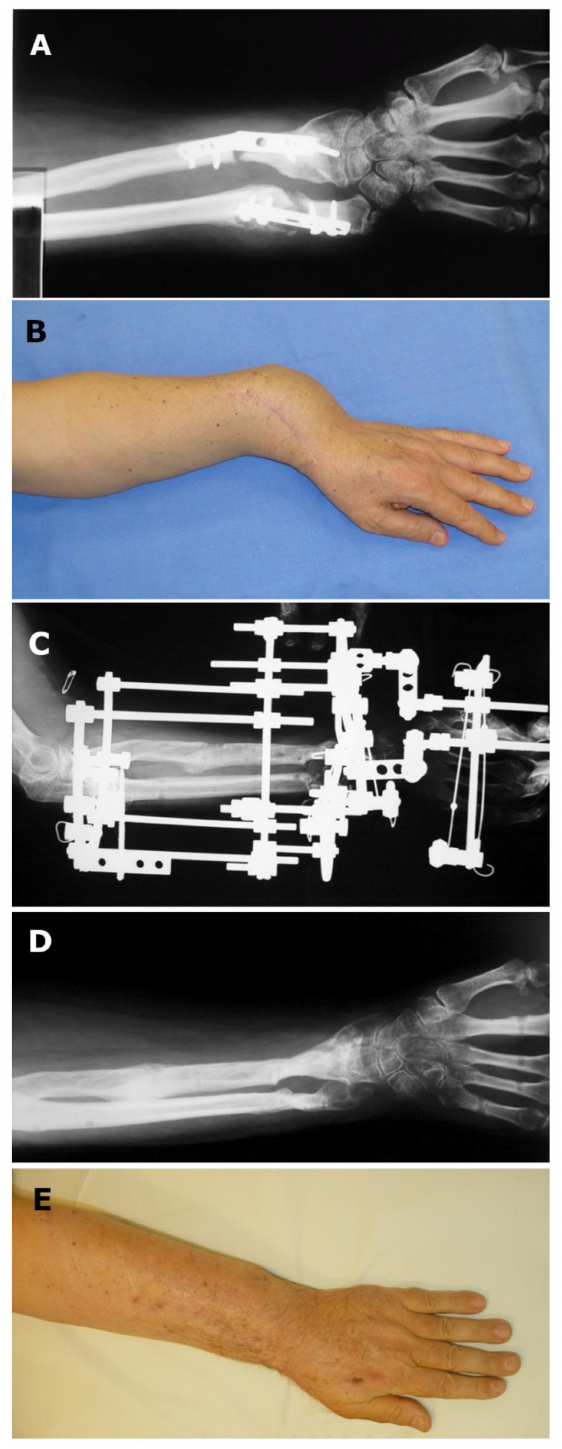
Figure 2. Nonunion. Male, 57 years old. Post-traumatic nonunion of the forearm, treated with plates ( A , B ). Ilizarov treatment for 6.5 months. Lengthening of the radius and compression at the level of the nonunion. Started LIPUS treatment (and continued for 60 days) ( C ). X-ray 3 months after fixator removal ( D ). Clinical healing with the restoration of forearm length, normal distal radius and ulna ratios, and wrist function ( E